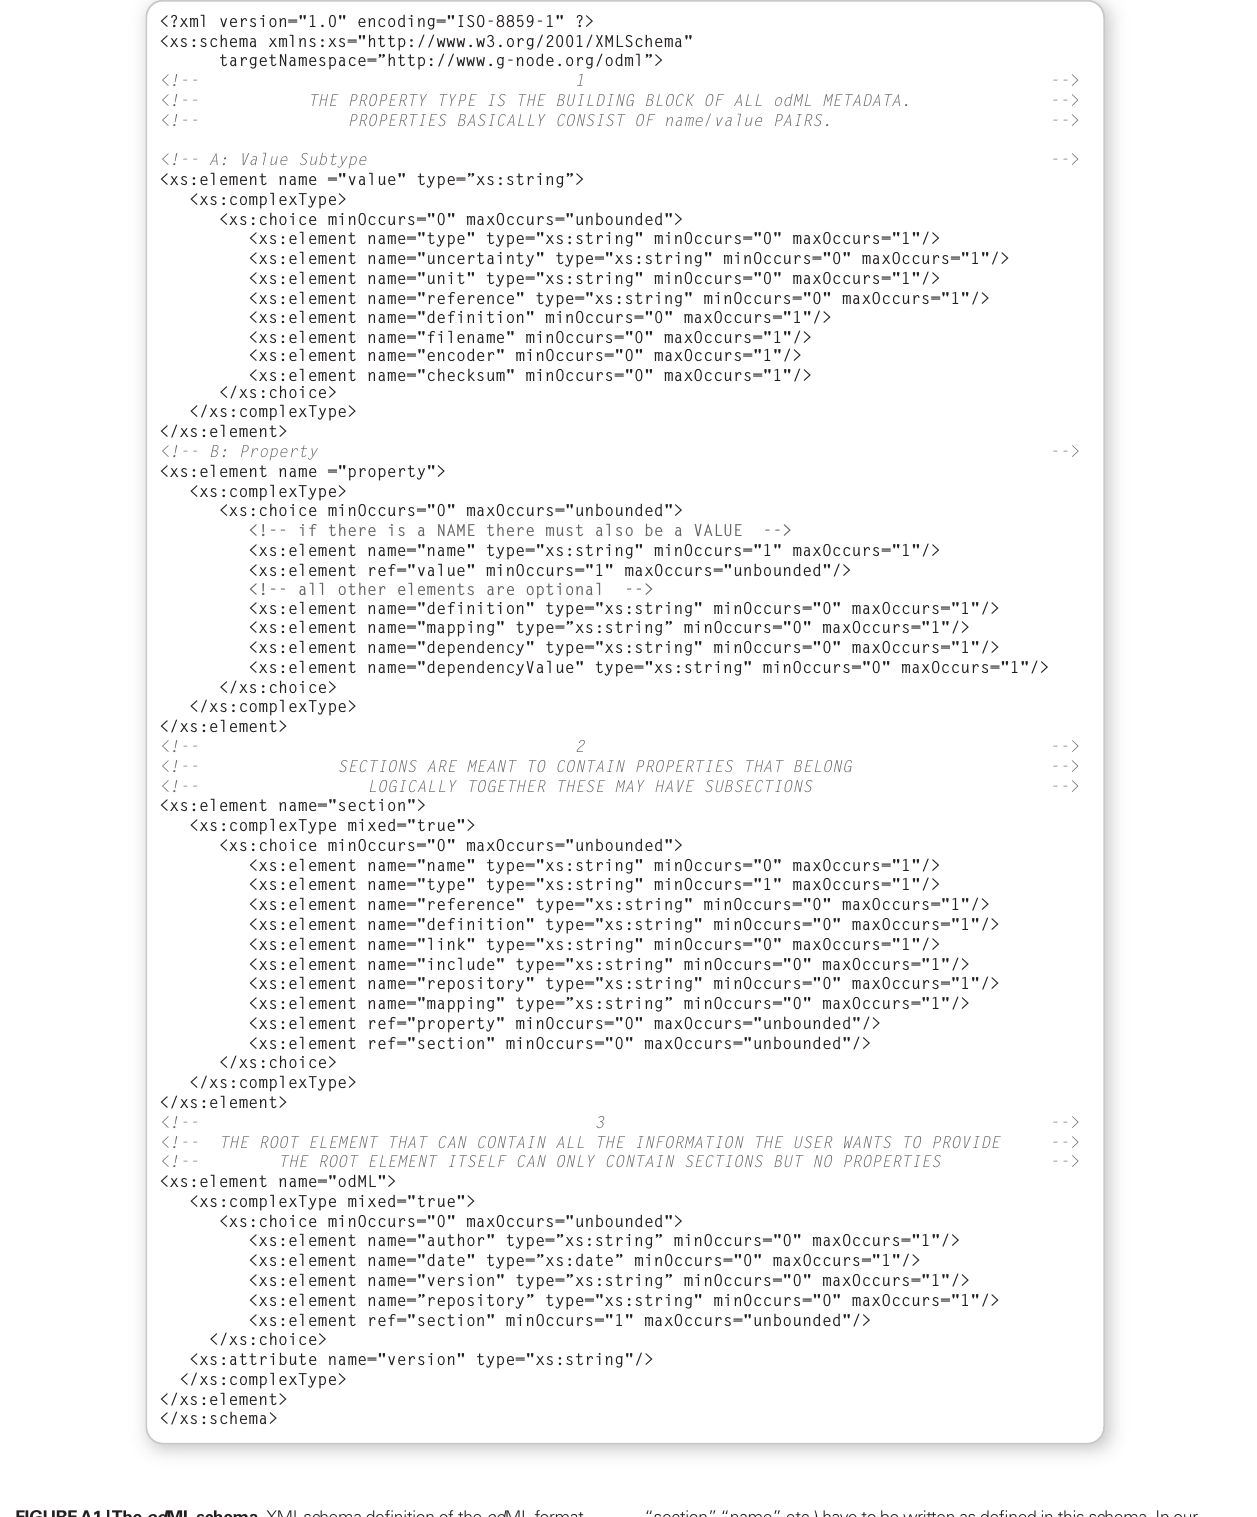
Figure A1 | The od ML schema. XML-schema definition of the od ML format. This schema can be used to validate od ML files, i.e., check their structural conformity. Note that XML is case-sensitive. This means that the tags (“property,”